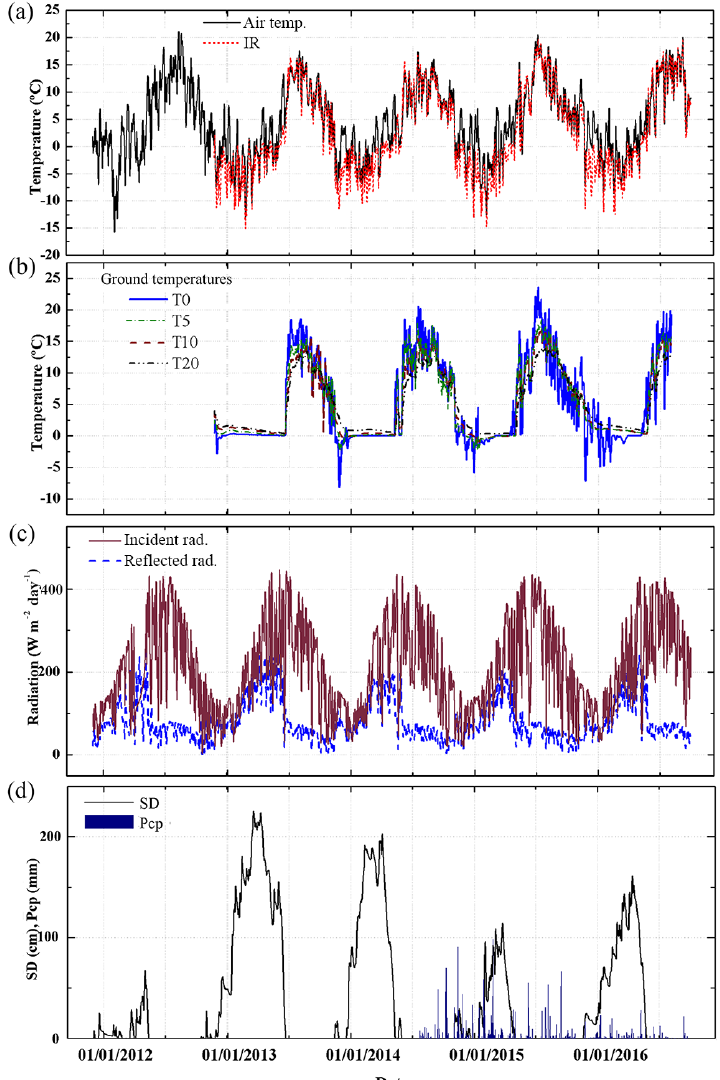
Figure 4. Temporal evolution of meteorological variables from 2011 to 2016. From top to bottom are air temperature and surface temperature (from the IR sensor); ground temperature for the four depths; global (Incident) and reflected solar irradiance; punctual snow depth (SD); and daily accumulated precipitation (Pcp) (sum of solid and liquid).